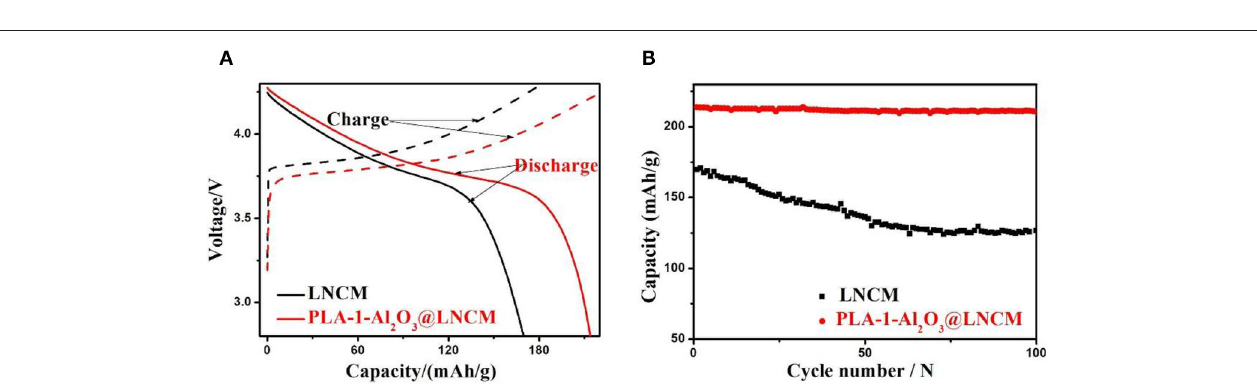
FIGURE 5 | (A) The initial discharge curves and (B) Discharge capacities vs. cycle number of LNCM and PLA-1-Al 2 O 3 @LNCM at the rate of 0.2 ◦ C in the voltage of 2.8–4.3V at room